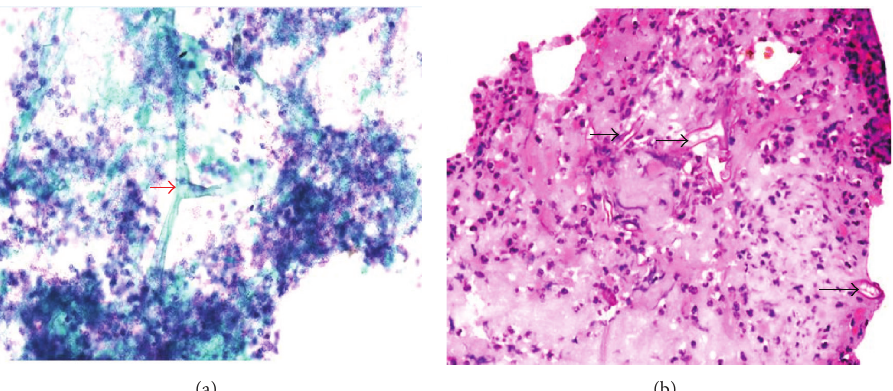
Figure 3: Bronchoalveolar lavage specimen showing broad, irregular, aseptate hyphae of Mucor with wide angled branching (arrow-heads) in a neutrophil-rich inflammatory background. (a) Papanicolaou (smear) × 600 and (b) haematoxylin and eosin (cell block) ×